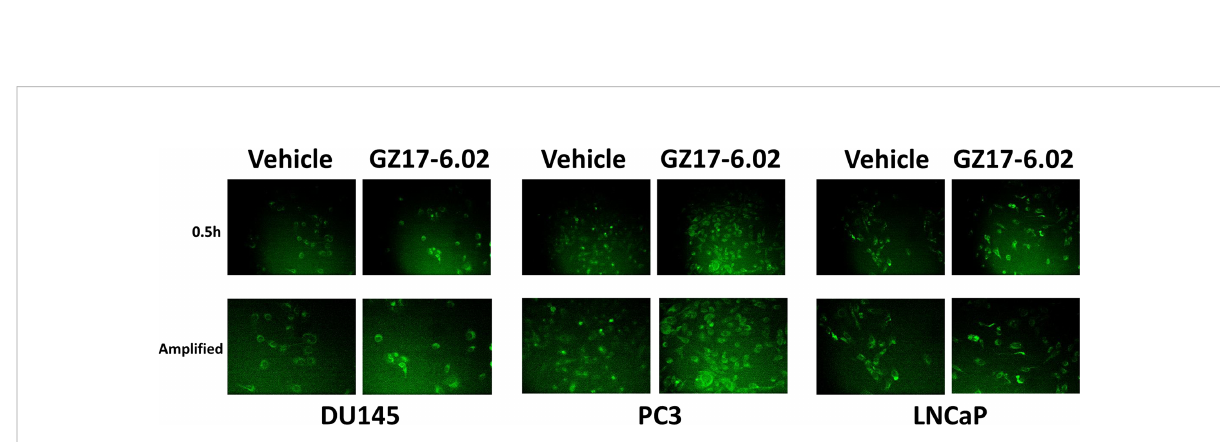
FIGURE 12 GZ17-6.02 rapidly activates ATM proteins localized around and outside of the nucleus. Cells were treated with vehicle control or with GZ17- 6.02 (2 m M). Cells were fi xed 0.5h and 1h after drug exposure. Cells were fi xed in situ, permeabilized, stained with the indicated validated primary antibodies and imaged with secondary antibodies carrying red- and green- fl uorescent tags. Total ATM protein levels and ATM localization within the cell did not alter over the time course (data not